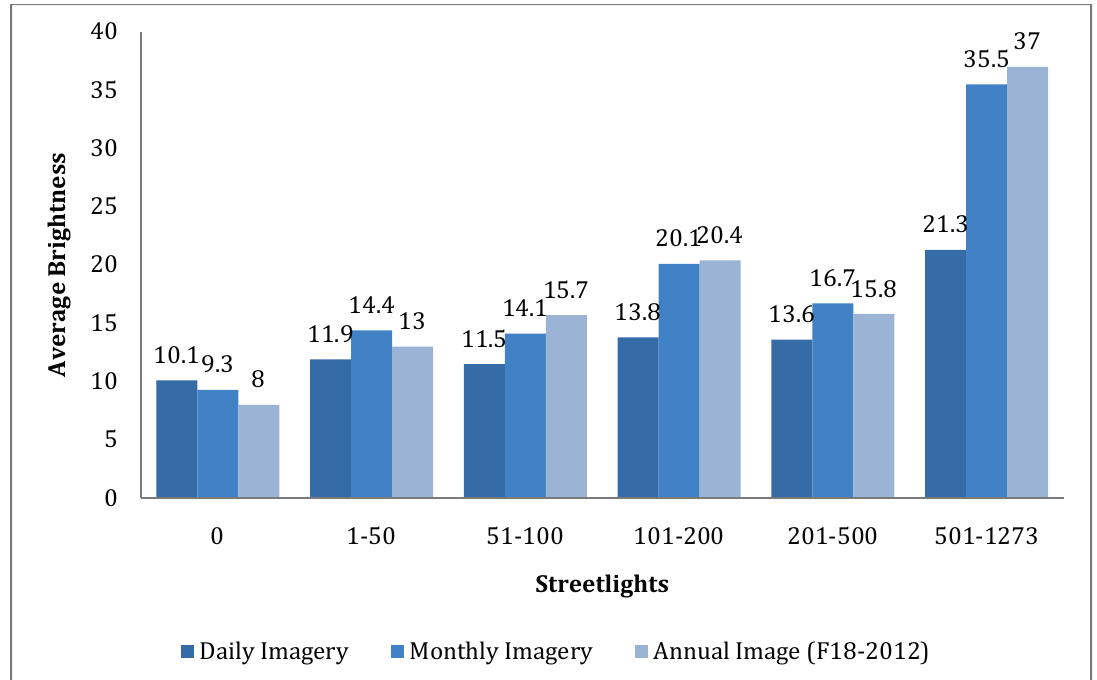
Figure 4. Nighttime light output and public